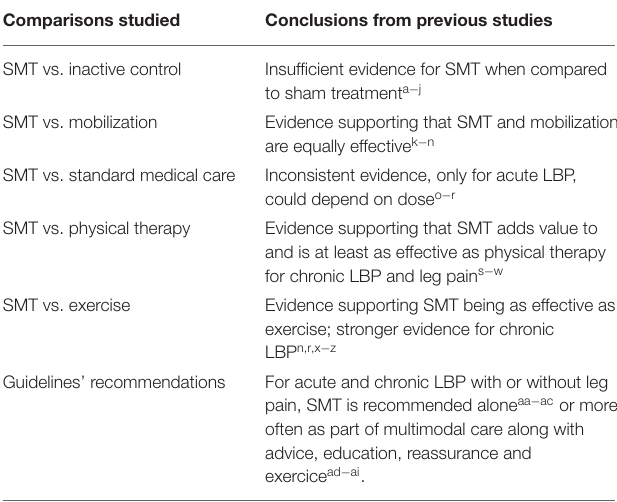
TABLE 2 | Effectiveness and efficacy (compared to inactive controls) of spinal manipulative therapy (SMT) for the management of low back pain (LBP). Comparisons